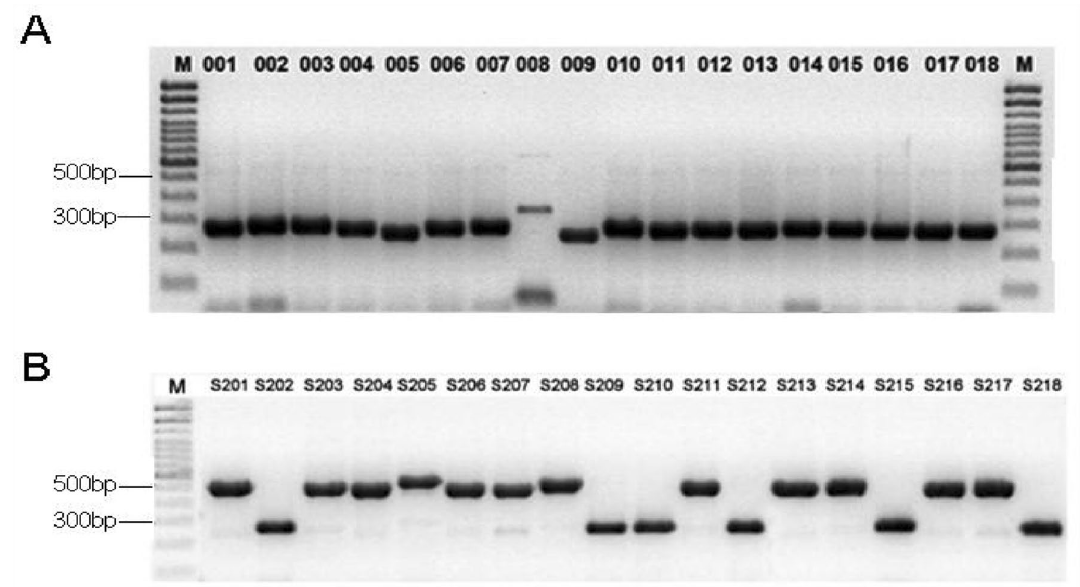
Figure 1. Molecular confirmation of sunflower and potato V. dahliae morphological mating types. PCR amplicons on gel after amplification with a MAT1-2F/R (upper) and MAT1-1F/R (below) specific primers for potato isolates and b MAT1-2F/R (upper) and MAT1-1F/R (below) specific primers for sunflower isolates. M; 100 bp DNA Ladder (110,488,058, Invitrogen,